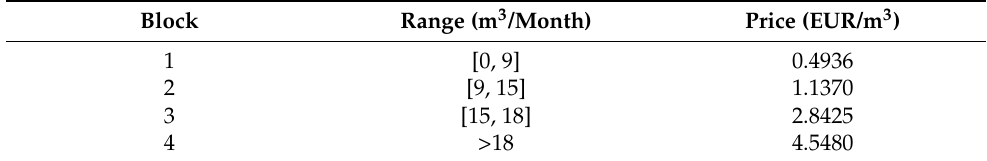
Table A7. Water regional tribute (Source: